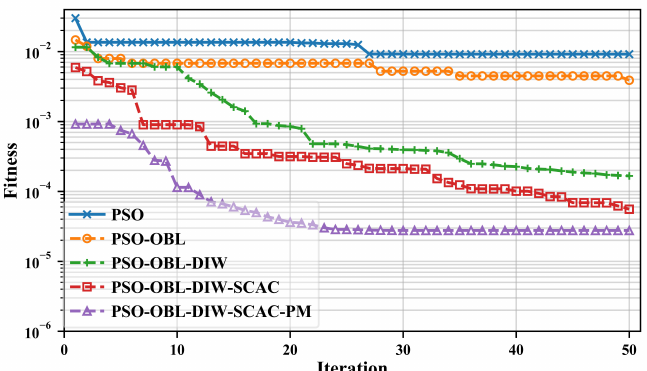
Figure 8. Comparison of the optimization process of different strategies in the five-layer geoelectric model test. The number of evolutionary iterations is 50. The blue line represents the supposed MT response. The green line represents the optimization process of traditional PSO. The yellow line represents the optimization process of PSO-OBL. The green line represents the optimization process of PSO-OBL-DIW. The red line represents the optimization process of PSO-OBL-DIW-SCAC. The red line represents the optimization process of